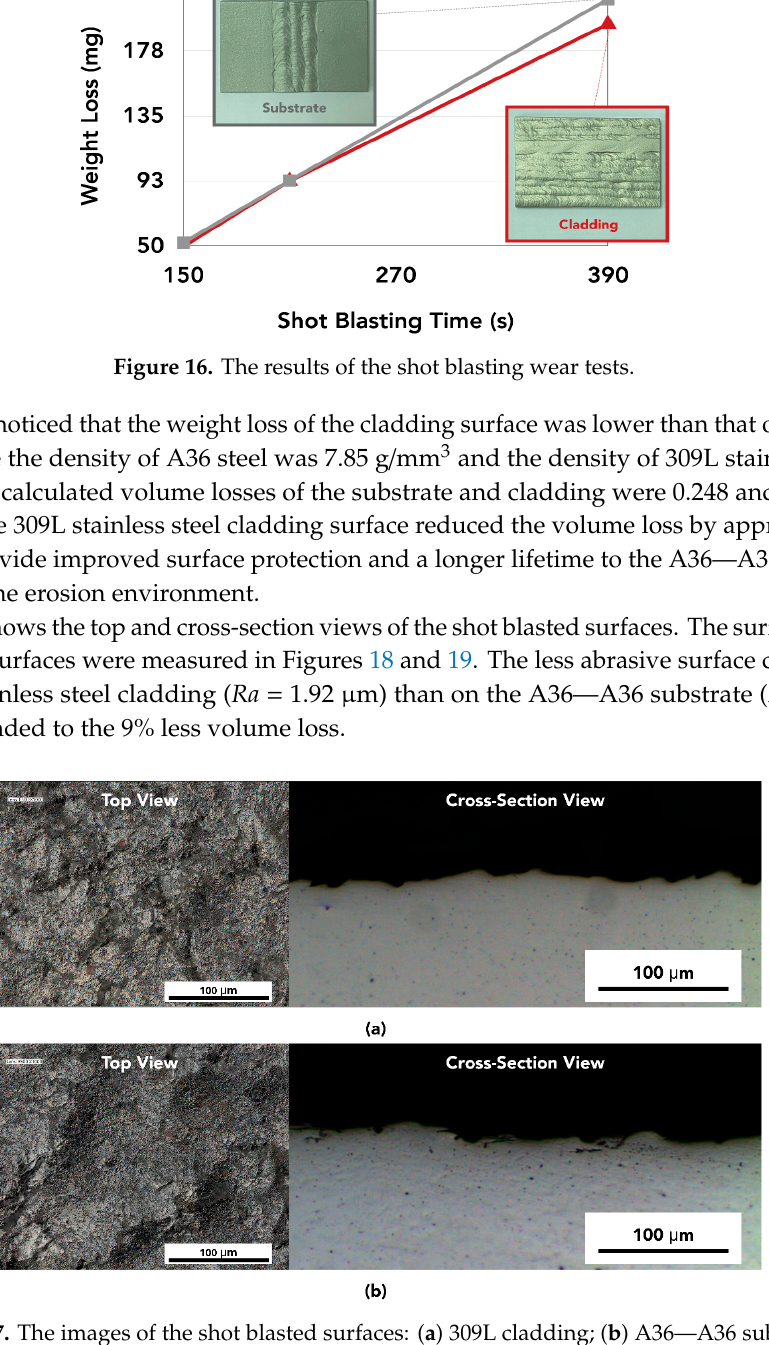
Figure 18. The measured surface roughness values of A36—A36 substrate.